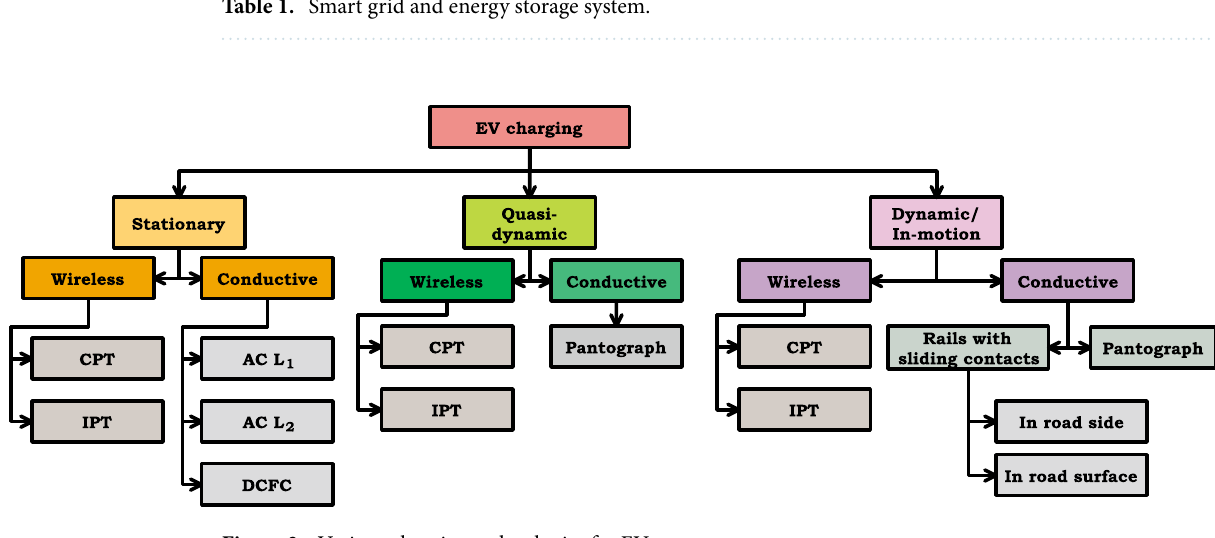
Figure 3. Various charging technologies for